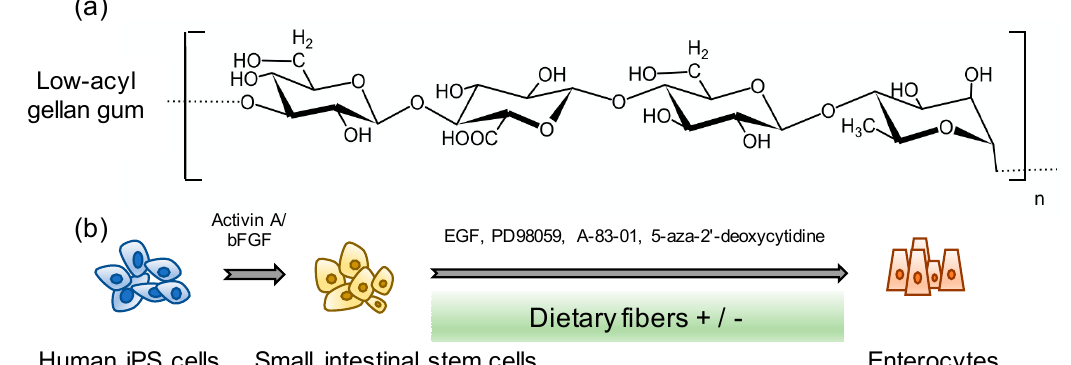
(a) Low-acyl gellan gum